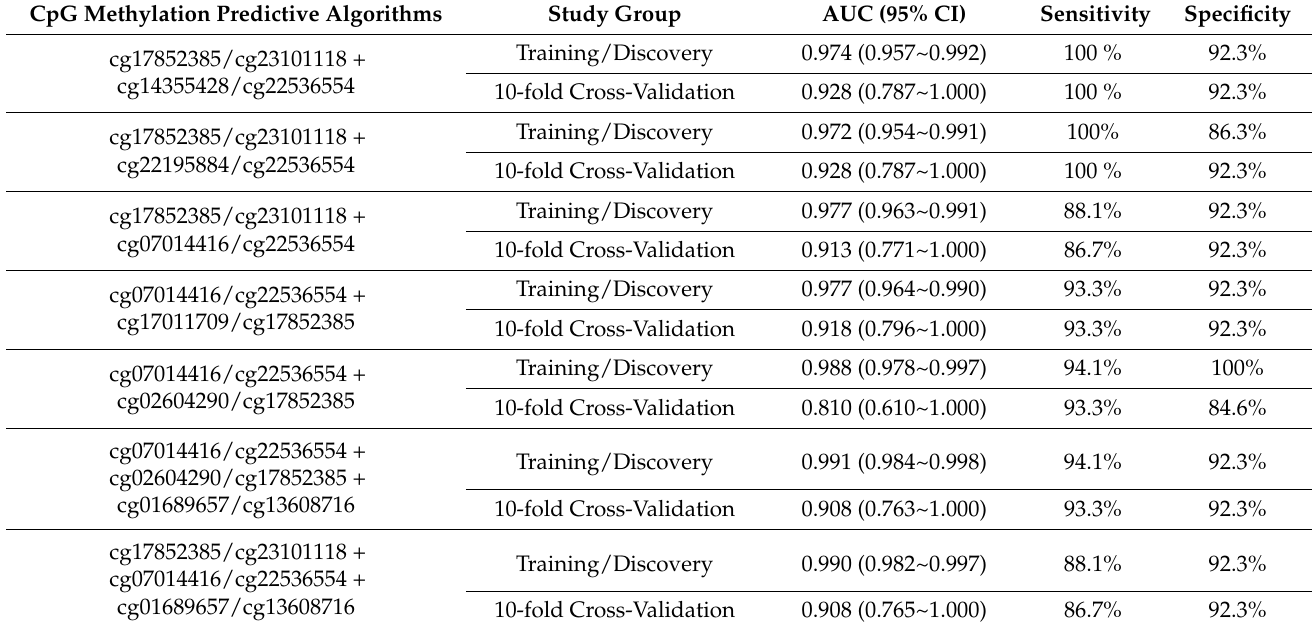
Table 2. Performance of top CpG methylation logistic regression models in discovery set (15 patients with Alzheimer’s disease (AD) vs. 13 controls).